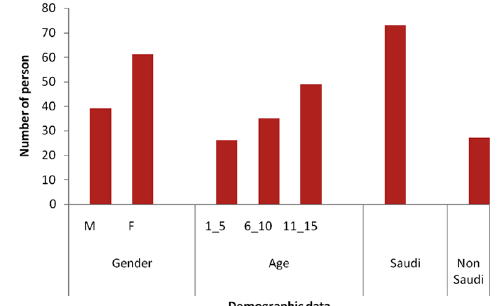
Fig. 1. Demographic data of vitamin D deficiency survey.